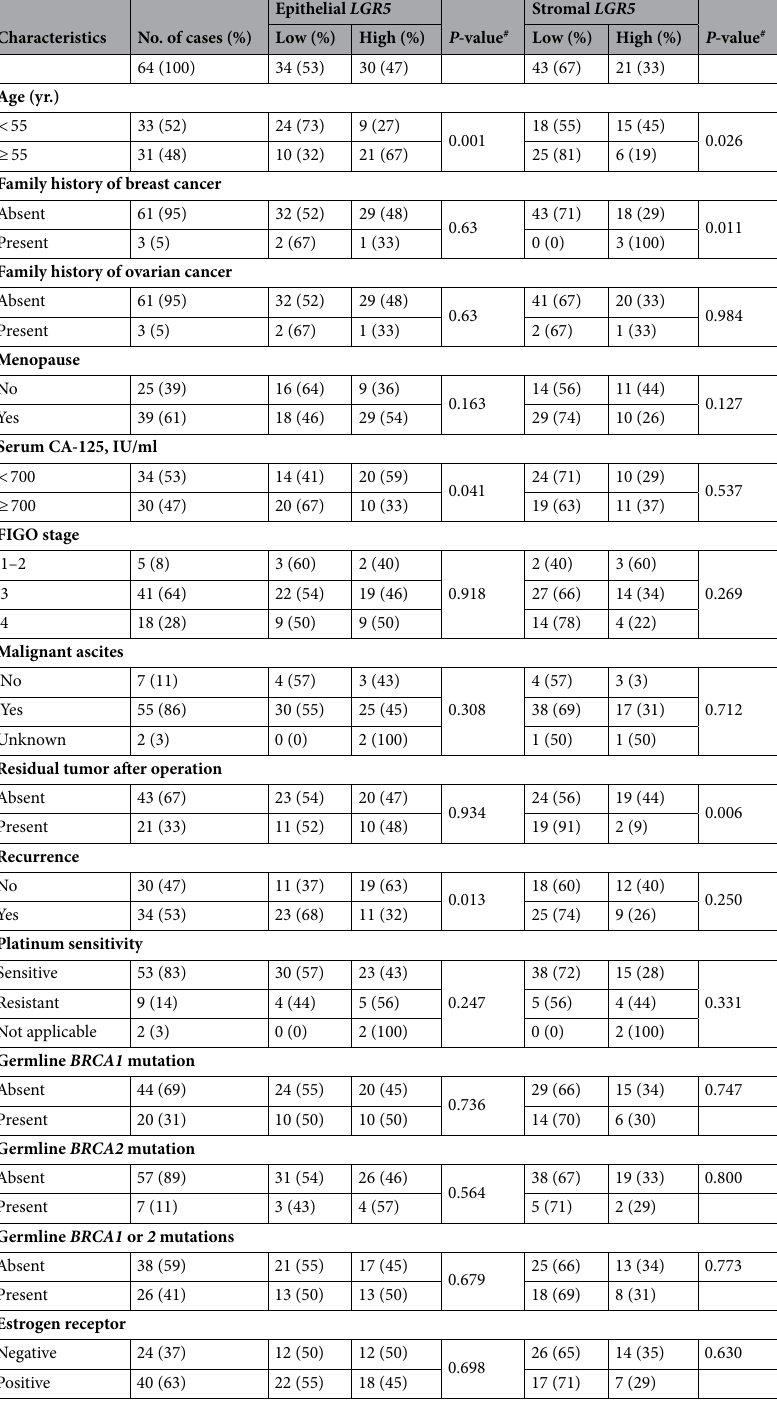
Table 1. Association between LGR5 and clinicopathological characteristics in high-grade serous carcinomas. No. Number; FIGO International Federation of Gynecology and Obstetrics. # Pearson chi-square